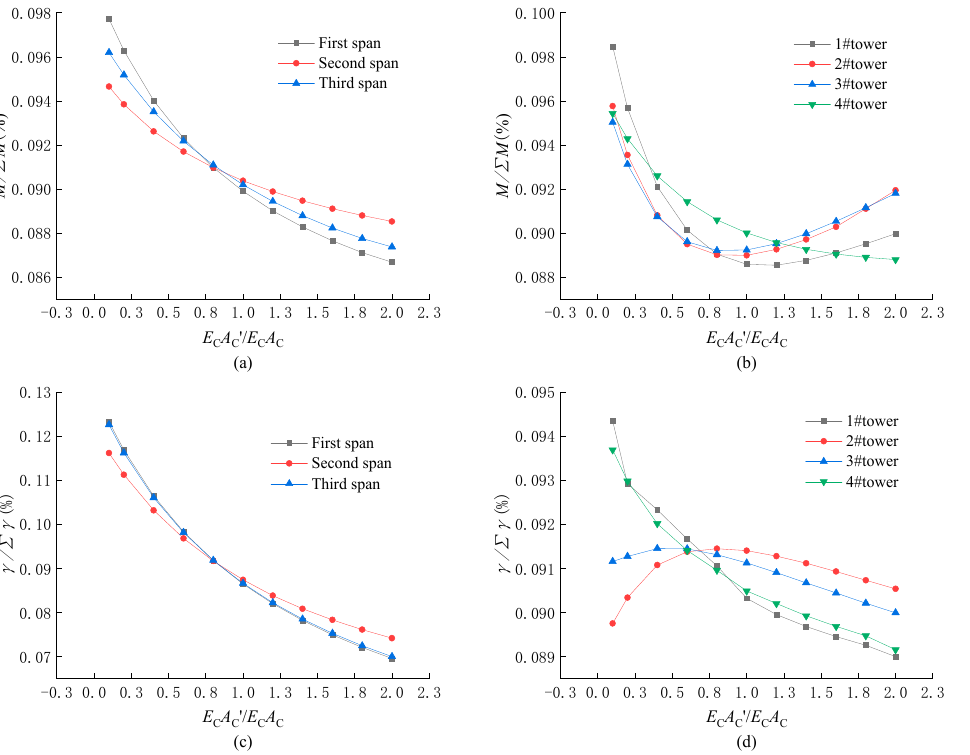
Figure 6. Comparisons of the structural effects caused by changes in stayed cable stiffness. ( a ) midspan bending moment; ( b ) moment at the root of the main girder tower; ( c ) midspan deflection. ( d ) tower top deflection.